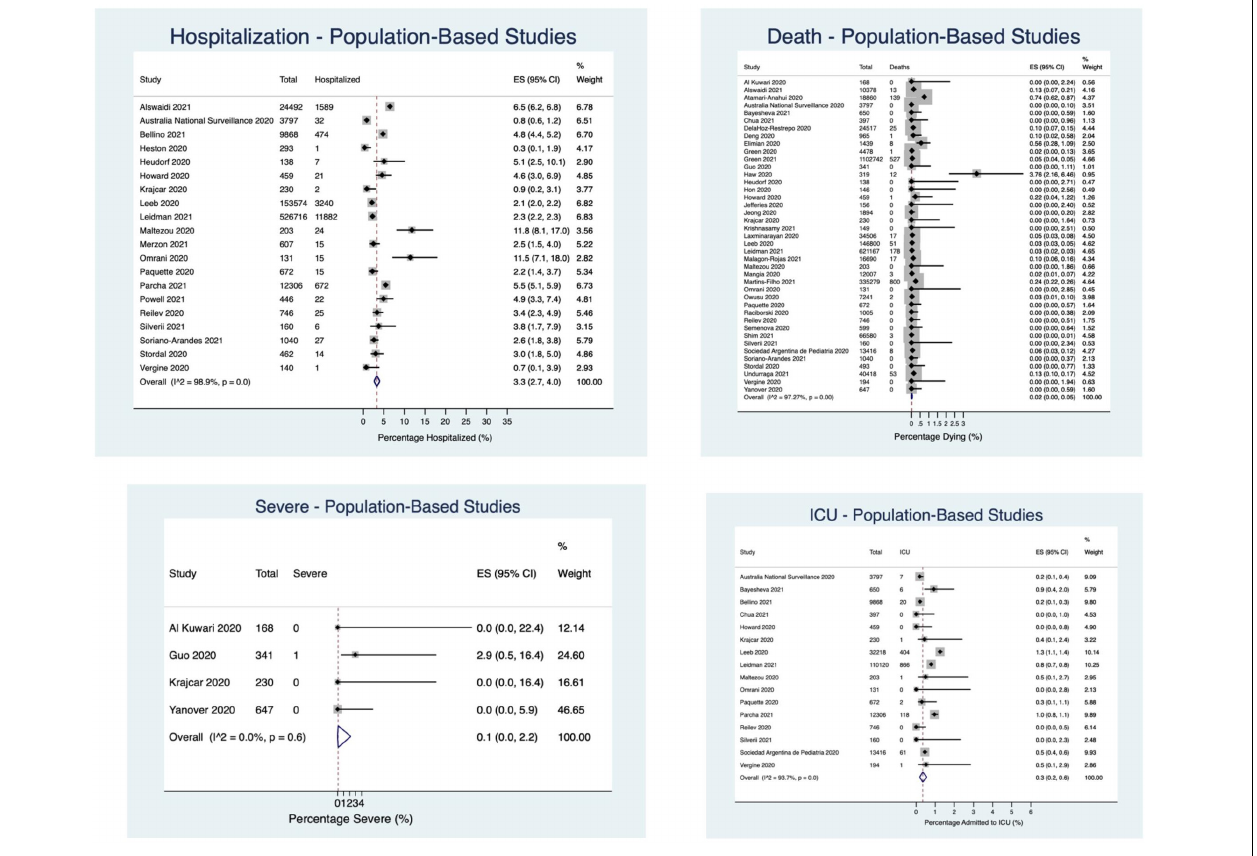
FIGURE 4 | Percentage of children experiencing outcomes in population-based